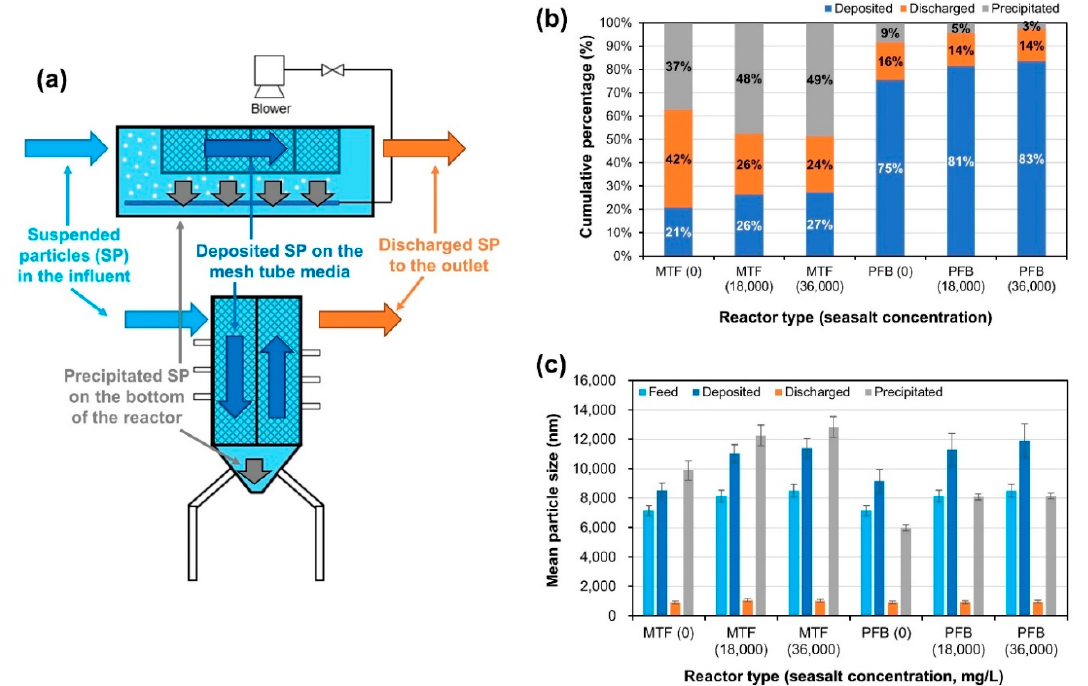
Figure 8. SP mass balance of bench-scale MTF and PFB reactors as a function of ionic concentration (artificial sea salt concentration: 0, 18,000, and 36,000 mg/L): ( a ) schematic diagram of mass balance; ( b ) deposited/discharged/precipitated particle ratio under each condition; ( c ) mean SP sizes under each condition.